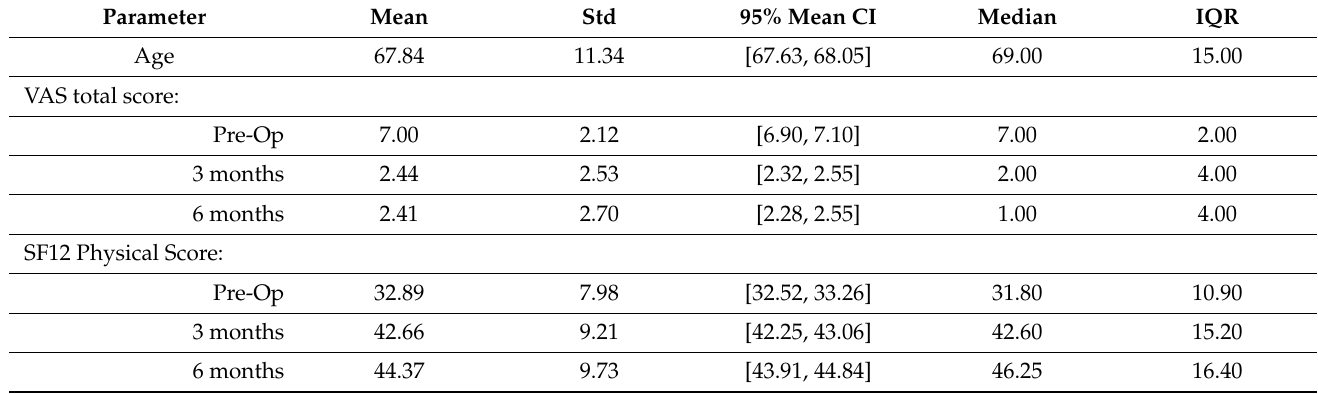
Table 1. Descriptive statistics. Heat Index is only calculated [26,27] when temperature ≥ 27 ◦ C and humidity >